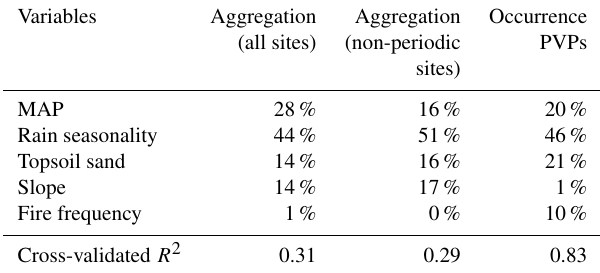
Table 2. Relative influence of each environmental variable and the cross-validated R 2 from the BRT models when modeling woody aggregation ( L function at 20m) and occurrence of PVPs. In the latter model, all sites with PVPs were given the value 1 and the rest the value 0.